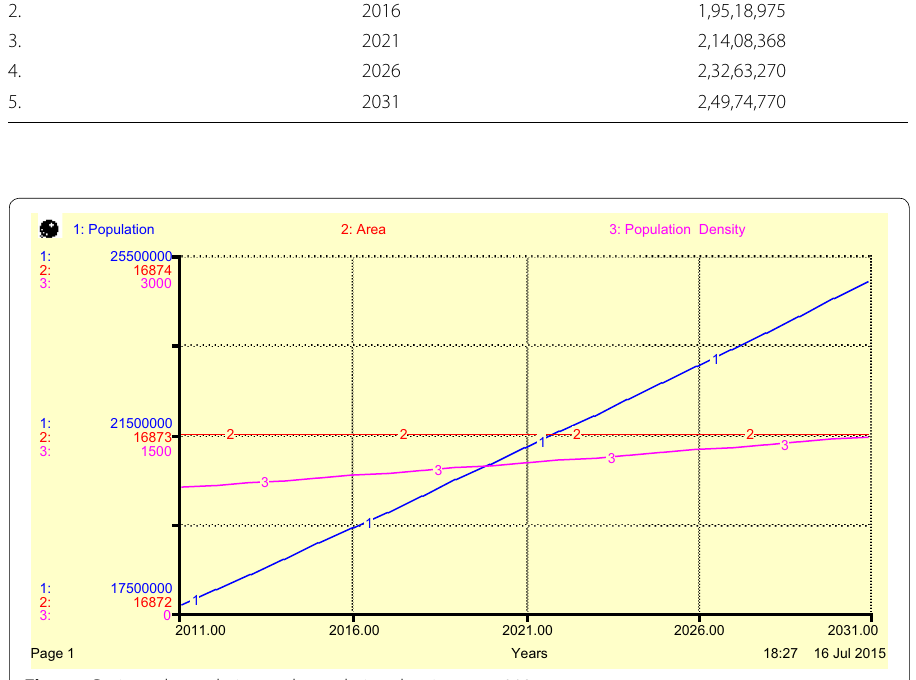
Fig. 11 Projected population and population density up to